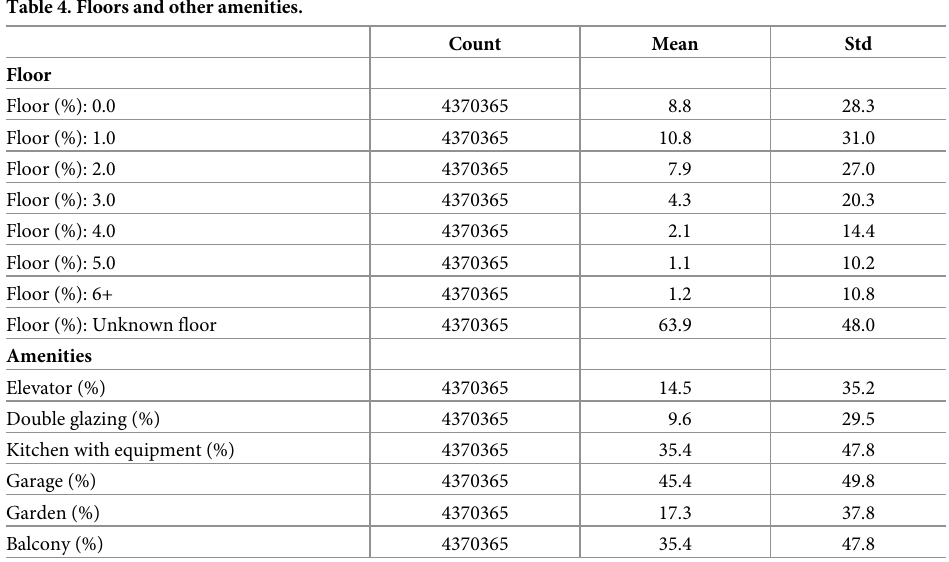
Table 4. Floors and other